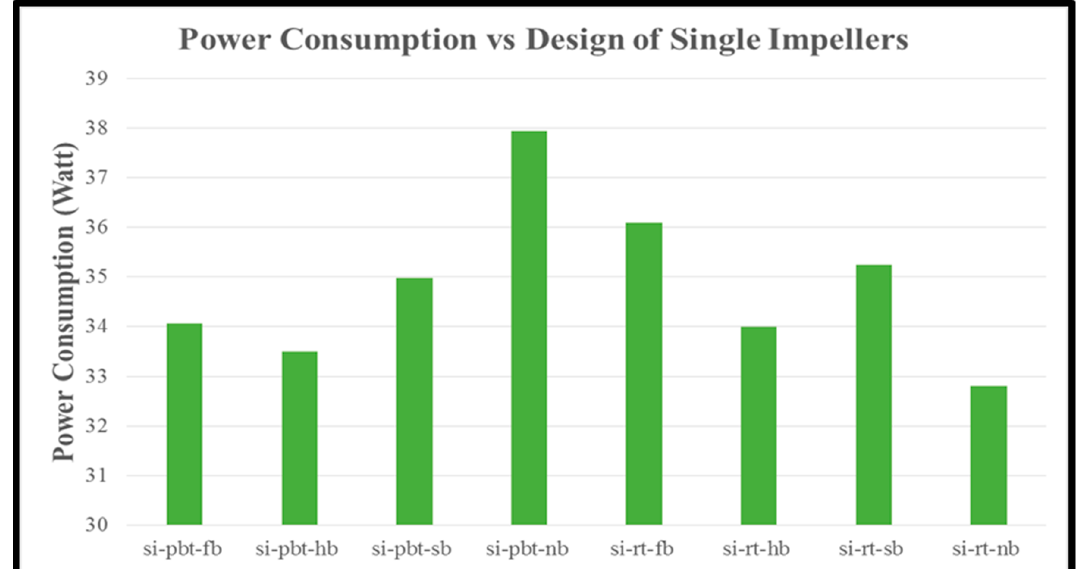
Figure 13. Power consumption of single impeller experiments.